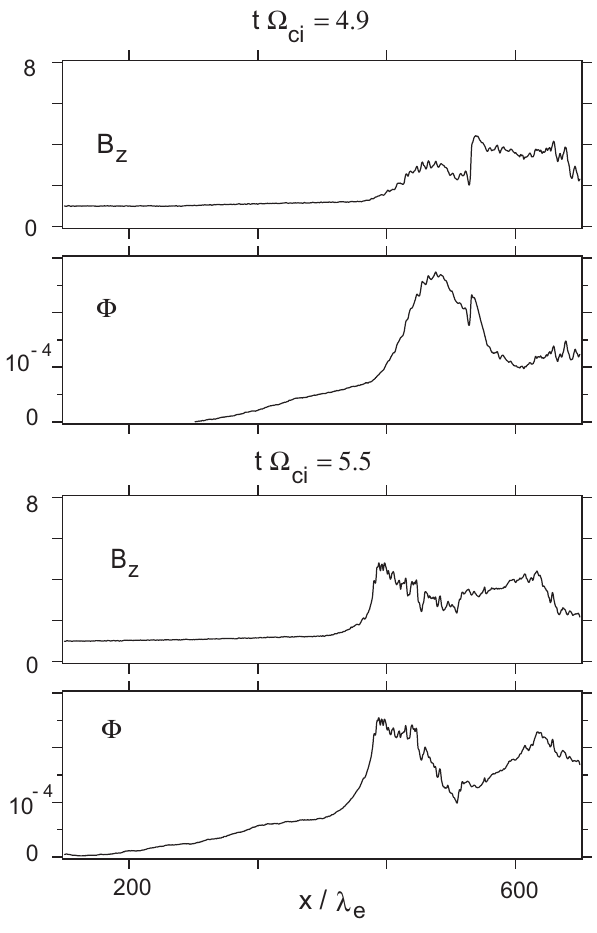
Fig. 6. Magnetic field B z component and cross shock potential 8 versus shock normal direction x for two different times during the reformation